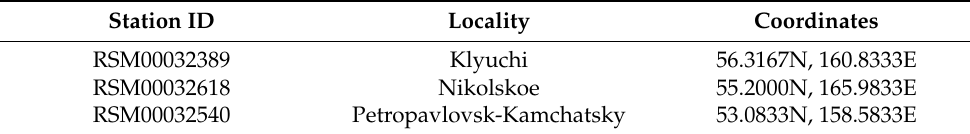
Table 1. Weather stations of Kamchatka and Bering Island in 1964. Station ID Locality